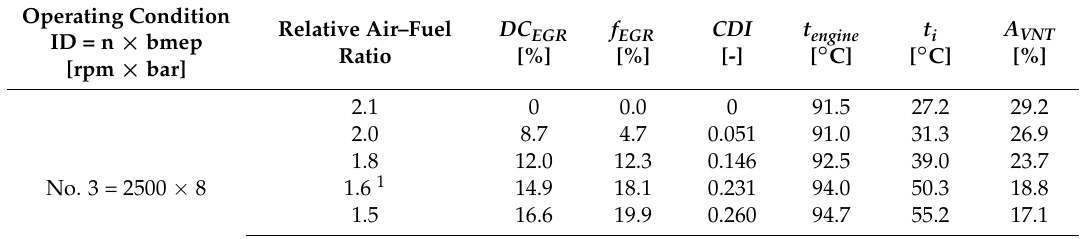
Table 3. Schedule of experimental activities (HP EGR trade-off, operating condition No. 3).